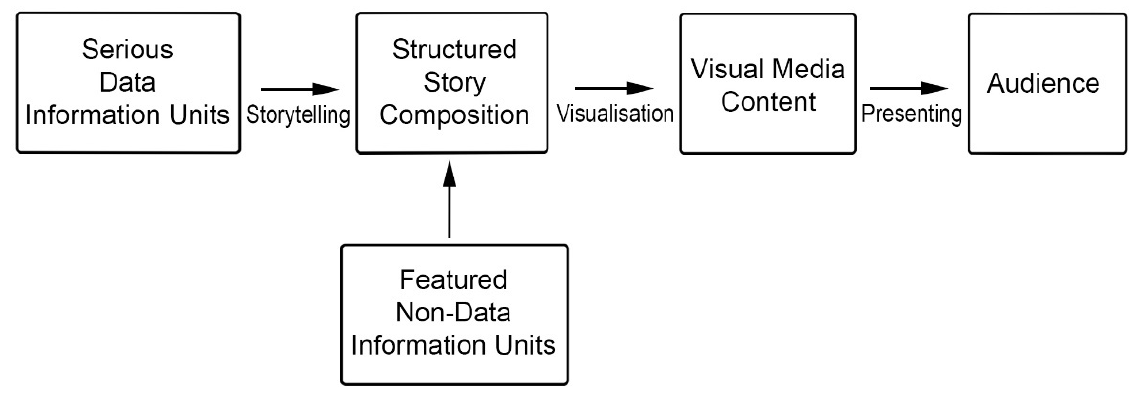
Figure 6. The basic process of visual data storytelling.